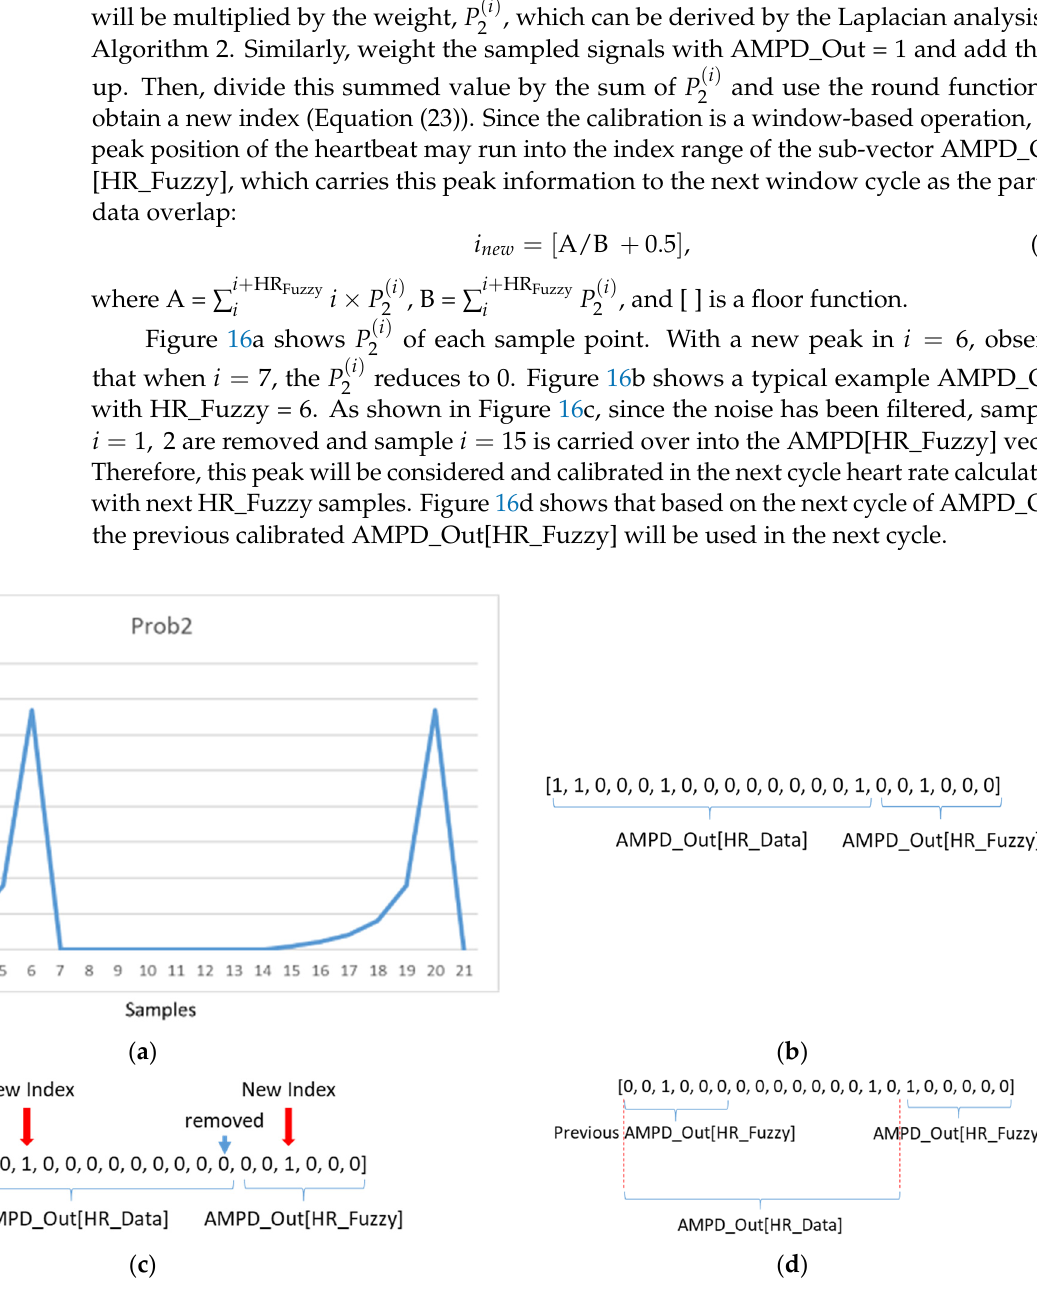
Figure 16. ( a ) An example of P of each sample point; ( b ) an example of a heart rate output vector; ( c ) an example of a calibrated heart rate output vector; ( d ) next cycle of heart rate output vector.